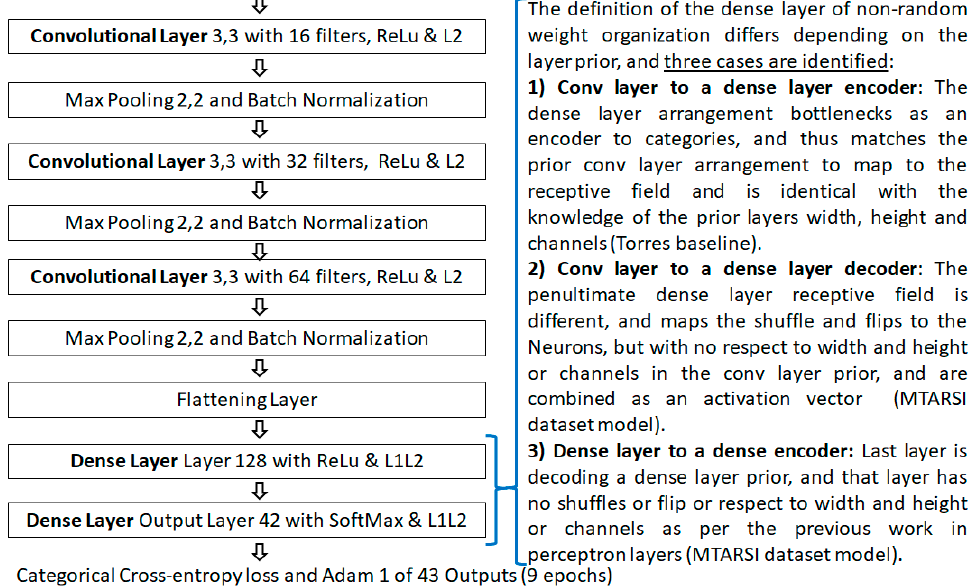
Figure 15. Color image model with dissimilar architecture, used for the MTARSI 2 [39] dataset.